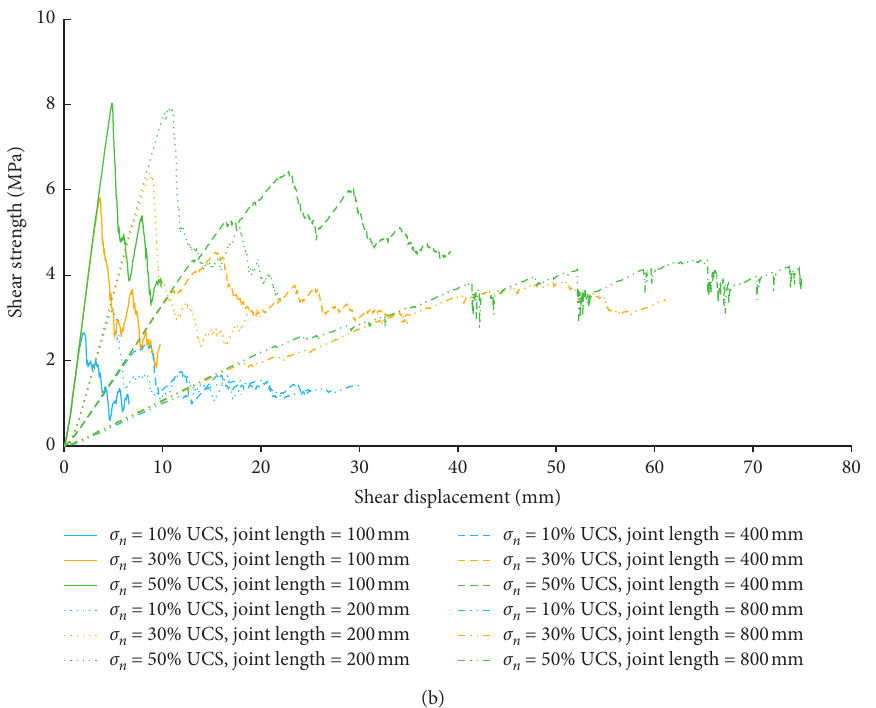
Figure 8: Shear stress-shear displacement curves of different-sized rock joints under CNL condition: (a) repeated and (b) enlarged rock joints derived from tenth standard JRC